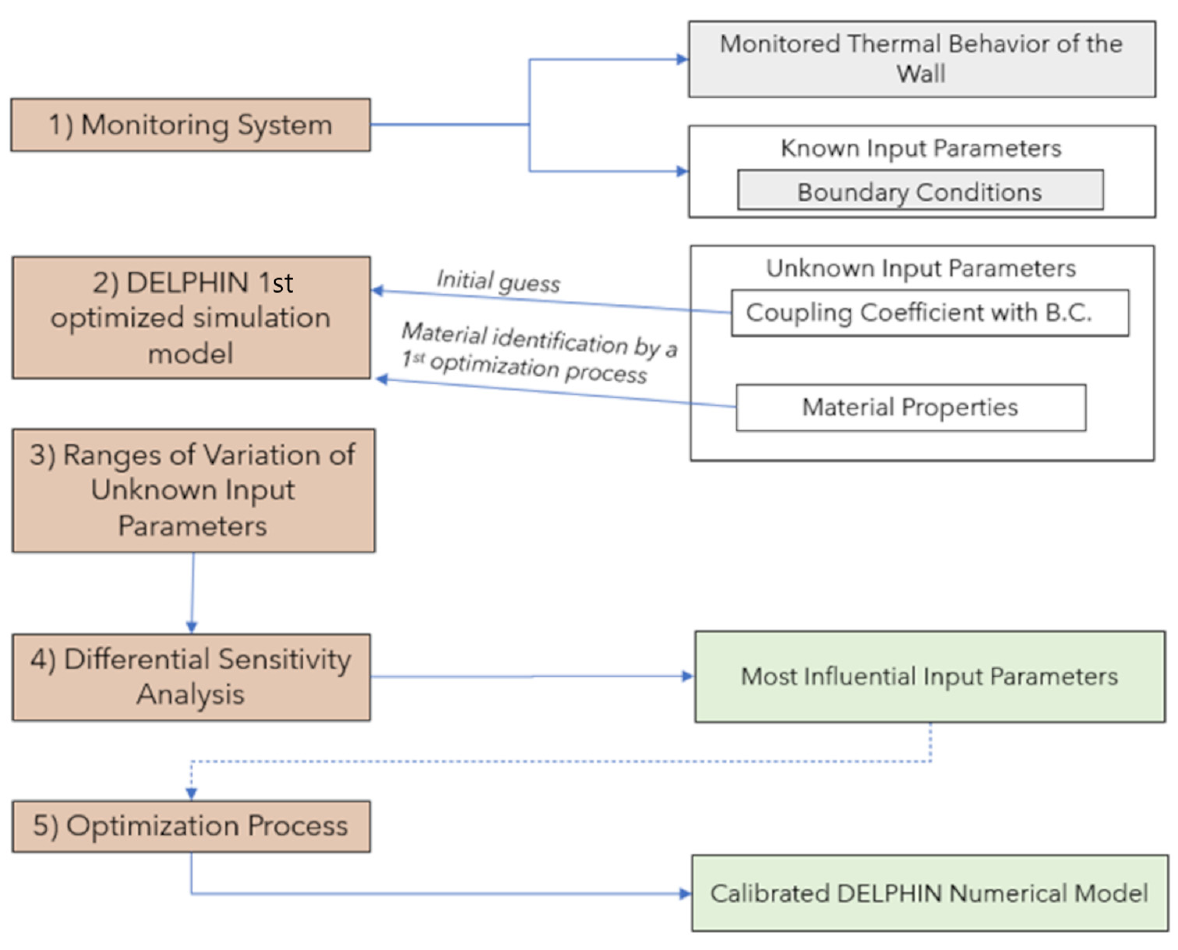
Figure 1. Flowchart of the methodology.